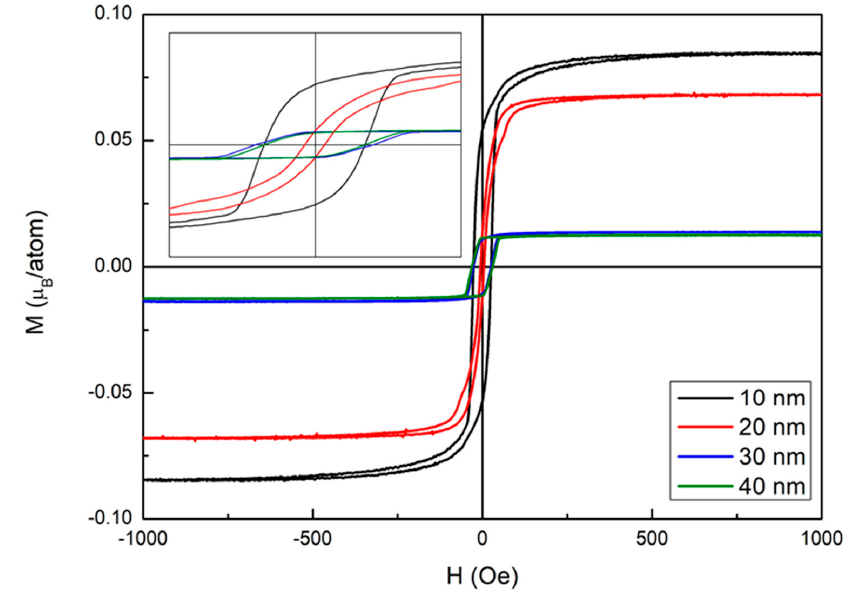
Figure 6. In-plane magnetic hysteresis loop of the Co 40 Fe 40 V 10 B 10 thin films.